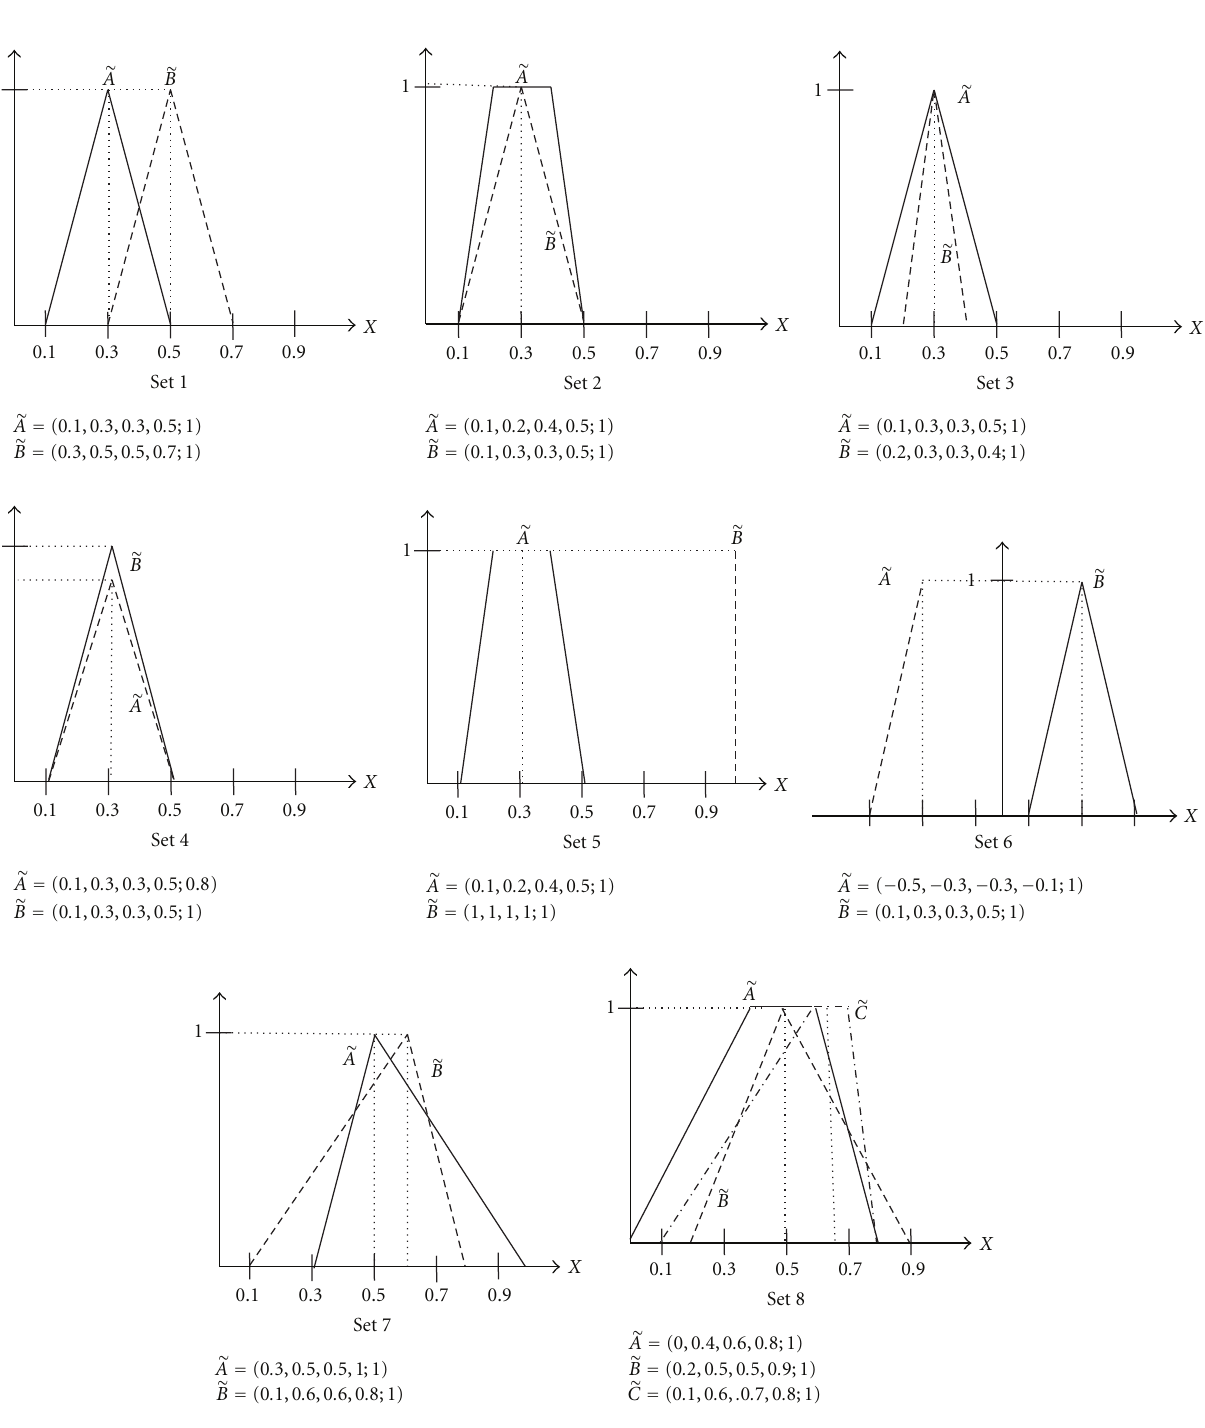
Figure 3: Group 2: seven sets of fuzzy numbers used to test the ranking algorithm